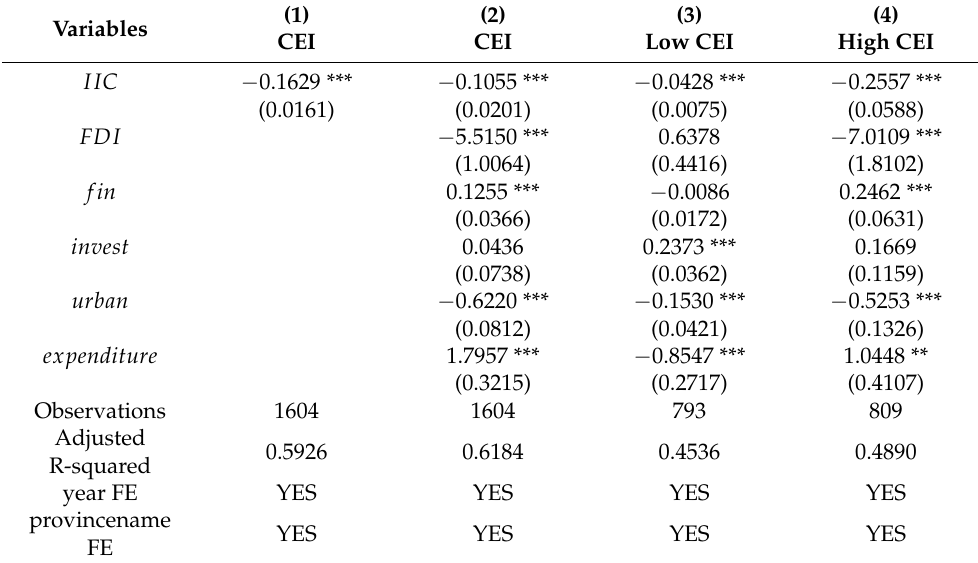
Table 2. Basic model: effect of IIC on